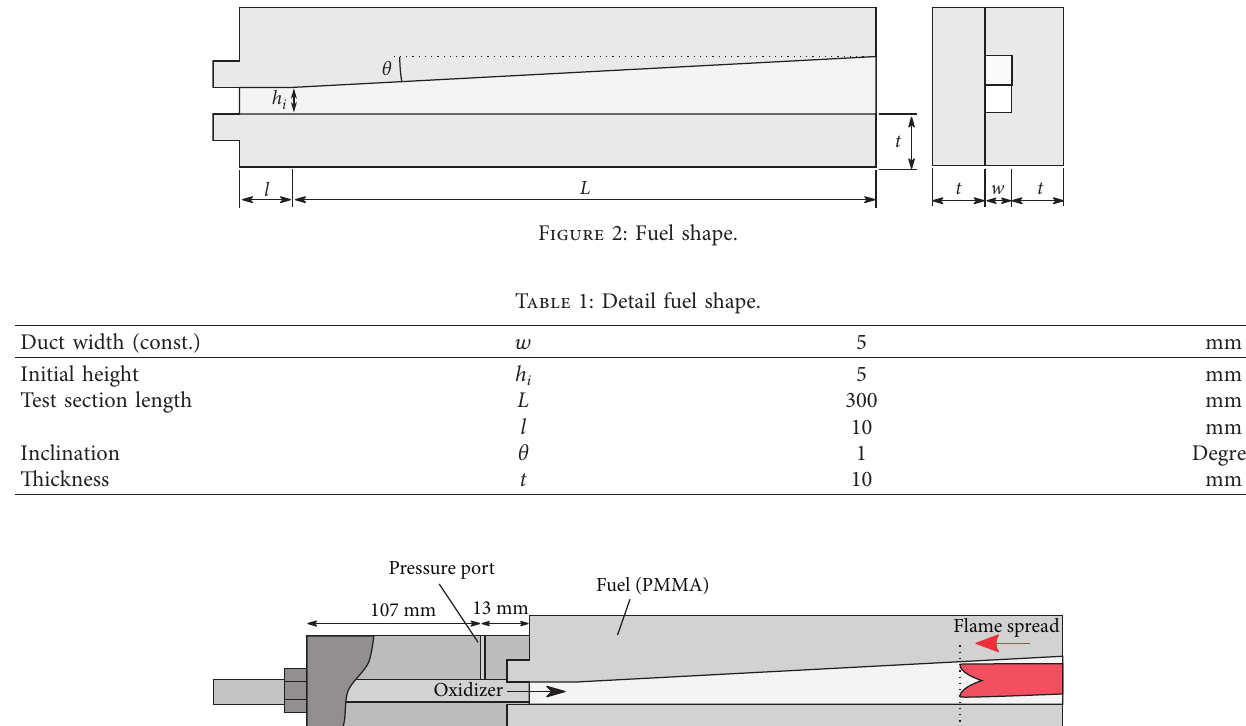
Figure 3: Test sample.